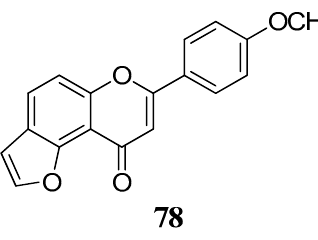
Figure 17. Structure of furanoflavonoid 78 .